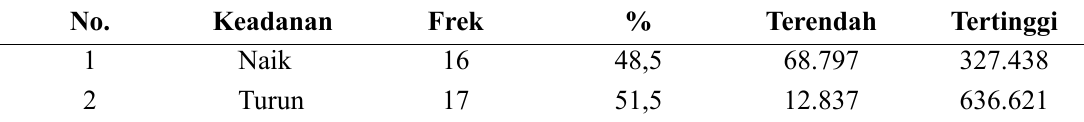
Tabel 7. Distribusi frekuensi kenaikan insentif menggunakan formula